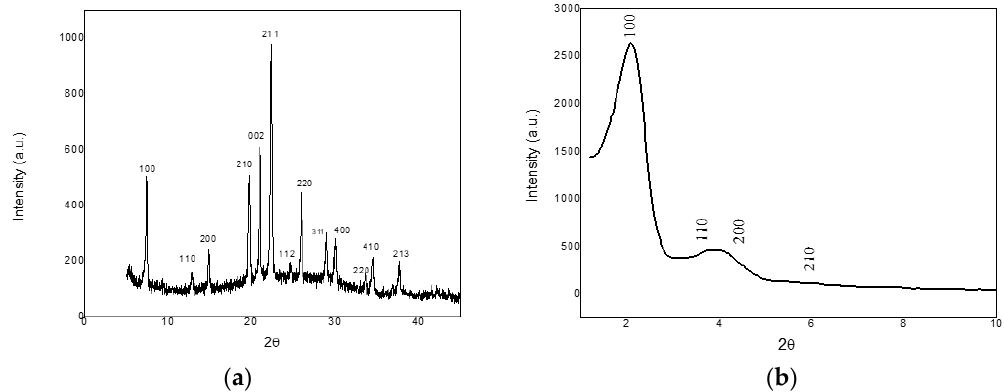
Figure 1. X-ray diffraction of SAPO-5 ( a ); X-ray diffraction of Al-MCM-41 ( b ) Figure 1. X-ray di ff raction of SAPO-5 ( a ); X-ray di ff raction of Al-MCM-41 ( b )